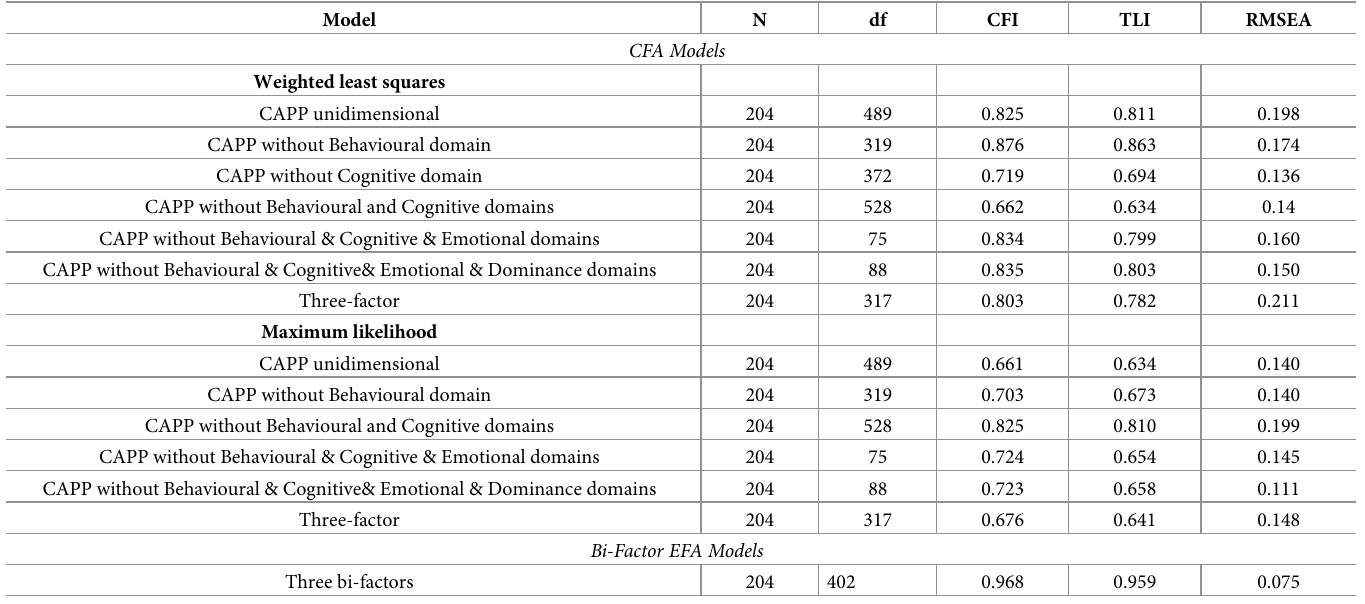
Table 5. CAPP Confirmatory factor analysis and bi-factor